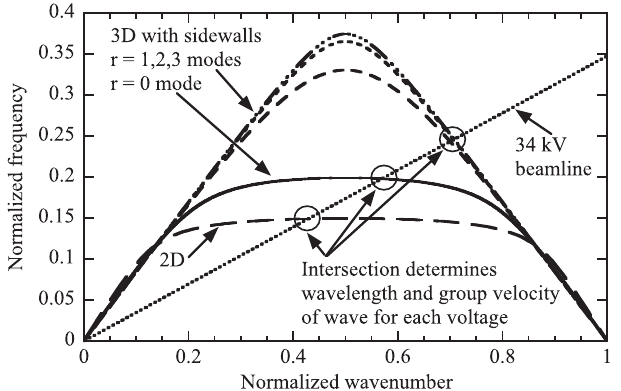
FIG. 1. Theoretical predictions for the dispersion relations for grating VBLT-001 by the 2D theory and 3D theory with walls. The intersection of the beam line and dispersion relation predict the wavelength and group velocity of the evanescent wave. The 2D theory predicts a longer wavelength and opposite group velocity compared to the 3D theory. Wavelength and wave number were normalized by L= 2 (cid:5) .